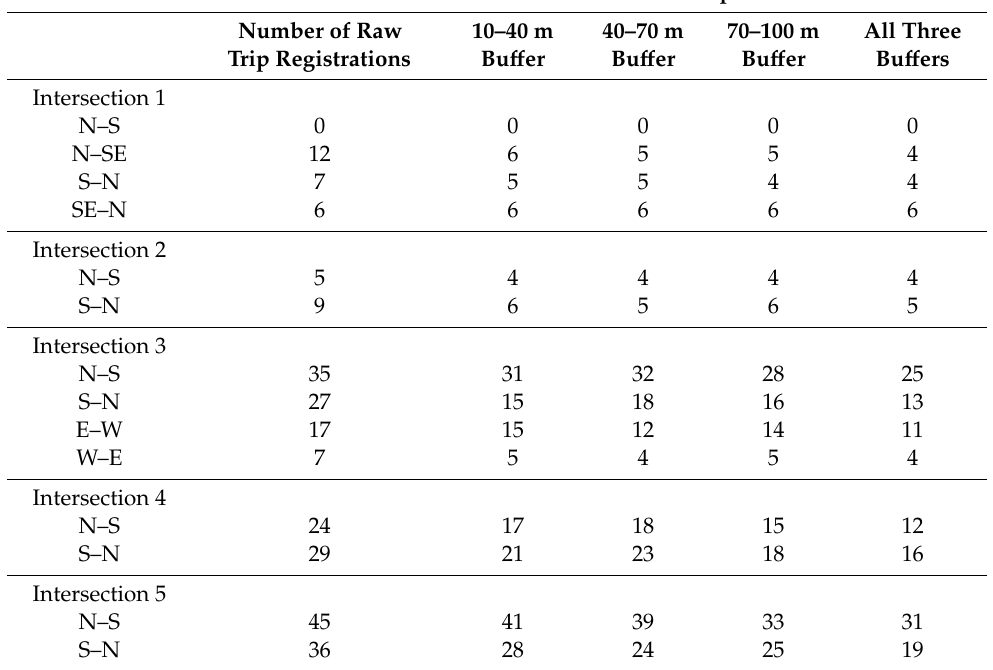
Table 1. Summary of the number of trip registrations in the bu ff ers of 10–40 m, 40–70 m, and 70–100 m before the